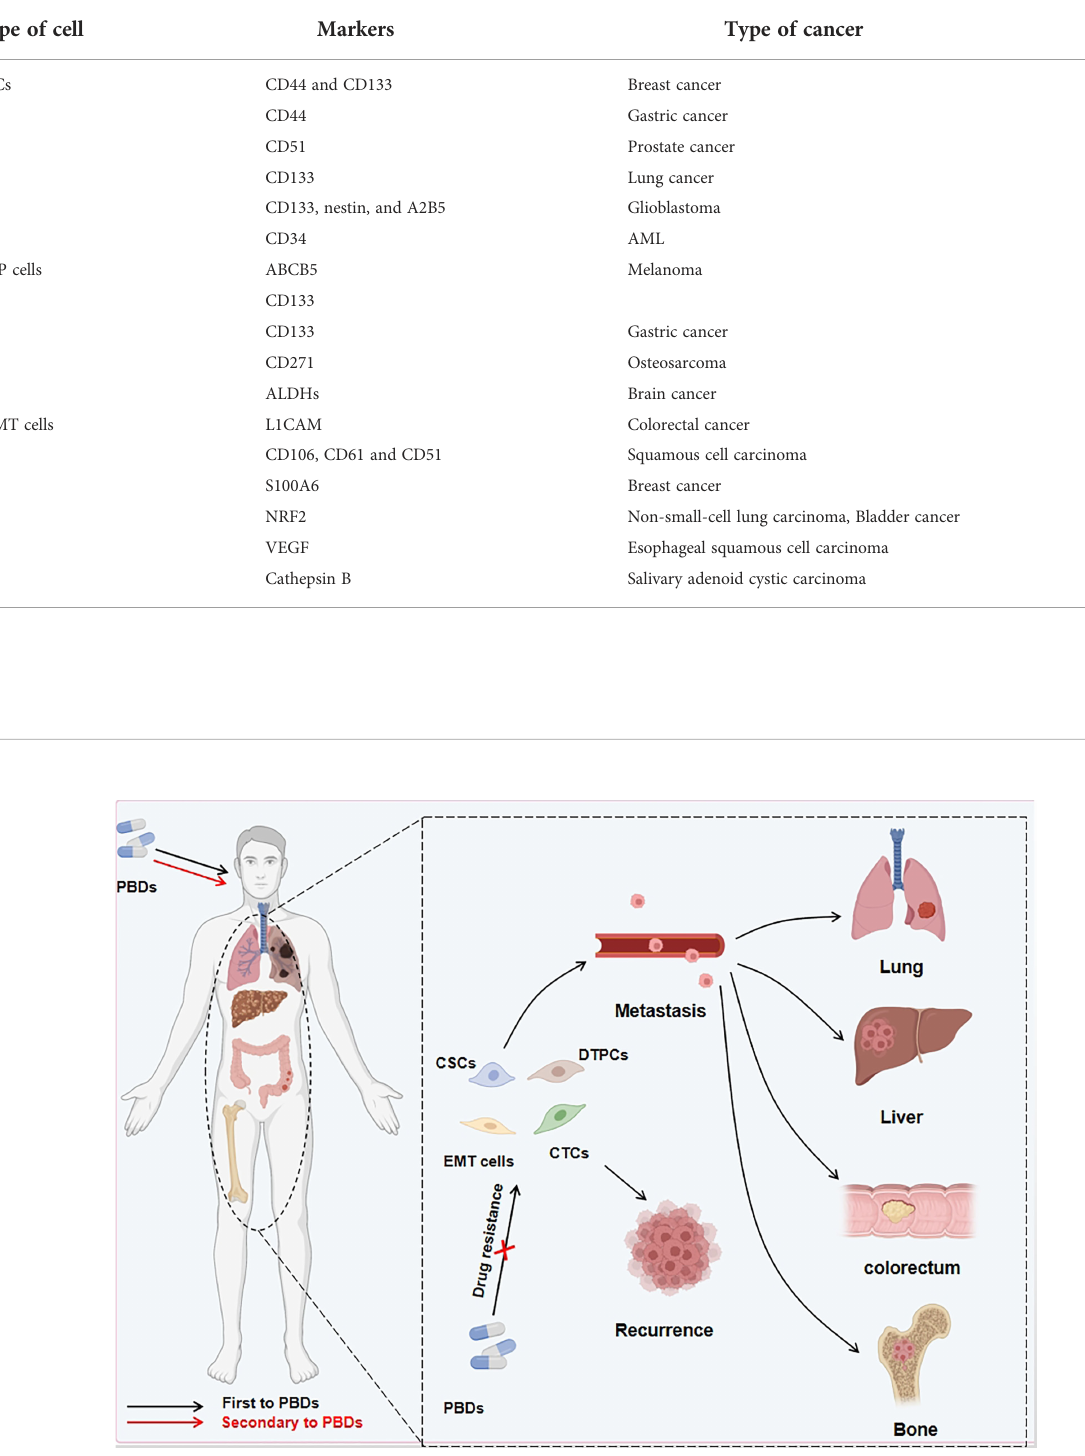
TABLE 3 Phenotypic differences of CSCs, DTP cells and pEMT cells.